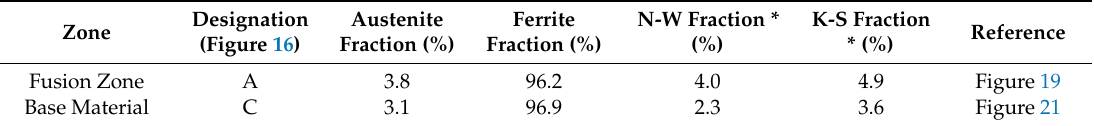
Table 6. Comparison of the phase fraction and the fraction of N-W and K-S orientations obtained by the EBSD